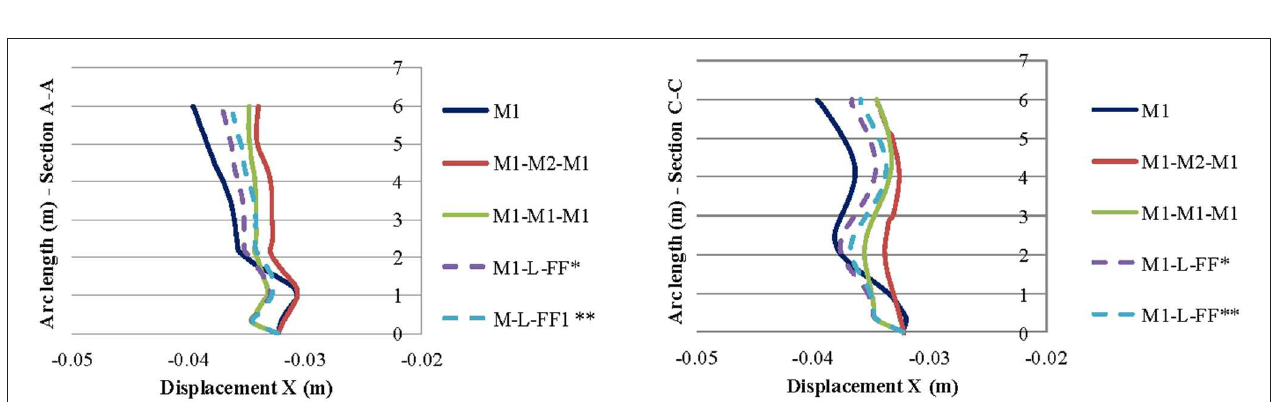
FIGURE 13 | Displacements X (in m) of sections A-A and C-C of models M1, M1-M1-M1, M1-M2-M1, and M1-L-FF (two cases) at 4s.